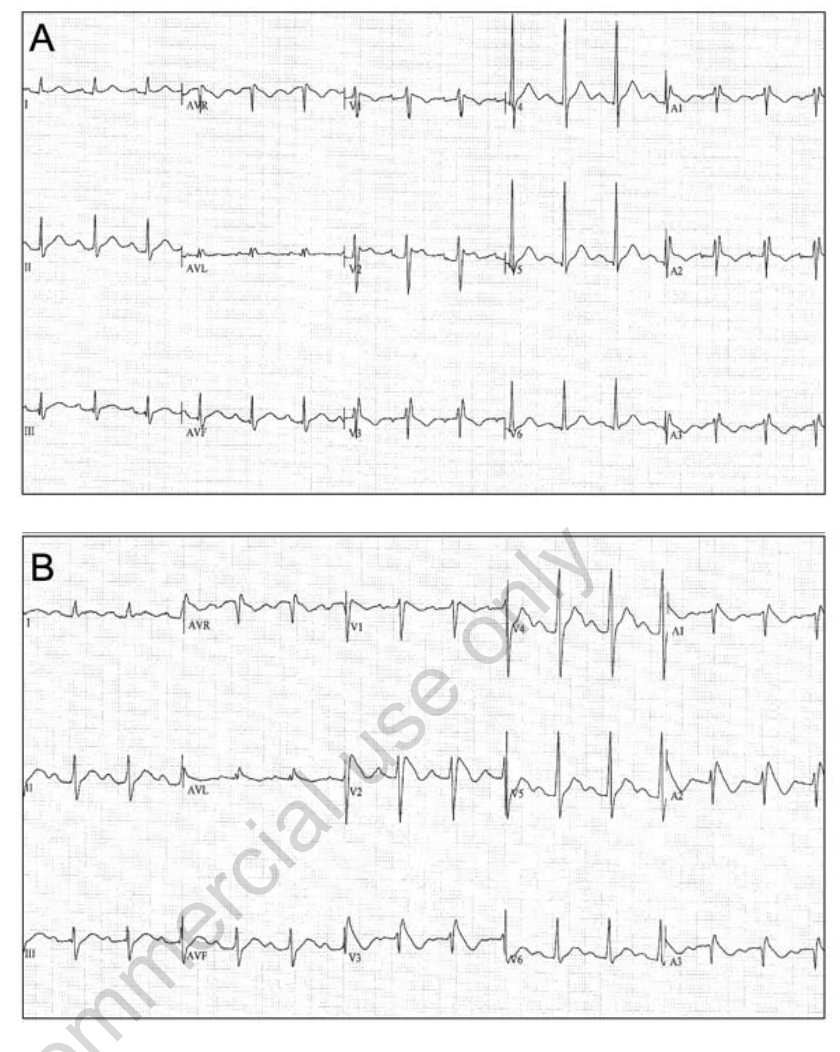
Figure 3. Ajmaline provocation testing in Brugada syndrome. Panel A demonstrates the baseline 12 lead electrocardiogram (ECG). Ajmaline is administered intravenously at a dose of 1 mg/kg over 5 min. Panel B demonstrates ECG changes at peak effect with a type 1 Brugada ECG pattern observed in standard leads V1/V2 and high leads V3/A1/A2/A3.* *For the purposes of ajmaline provocation testing A1/A2 represent V1/V2 in the third intercostal space and A3/V3 represent V1/V2 in the second intercostal space respectively.